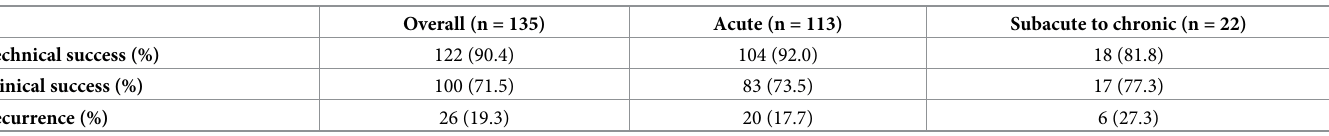
Table 4. Summary of outcomes based on stage.